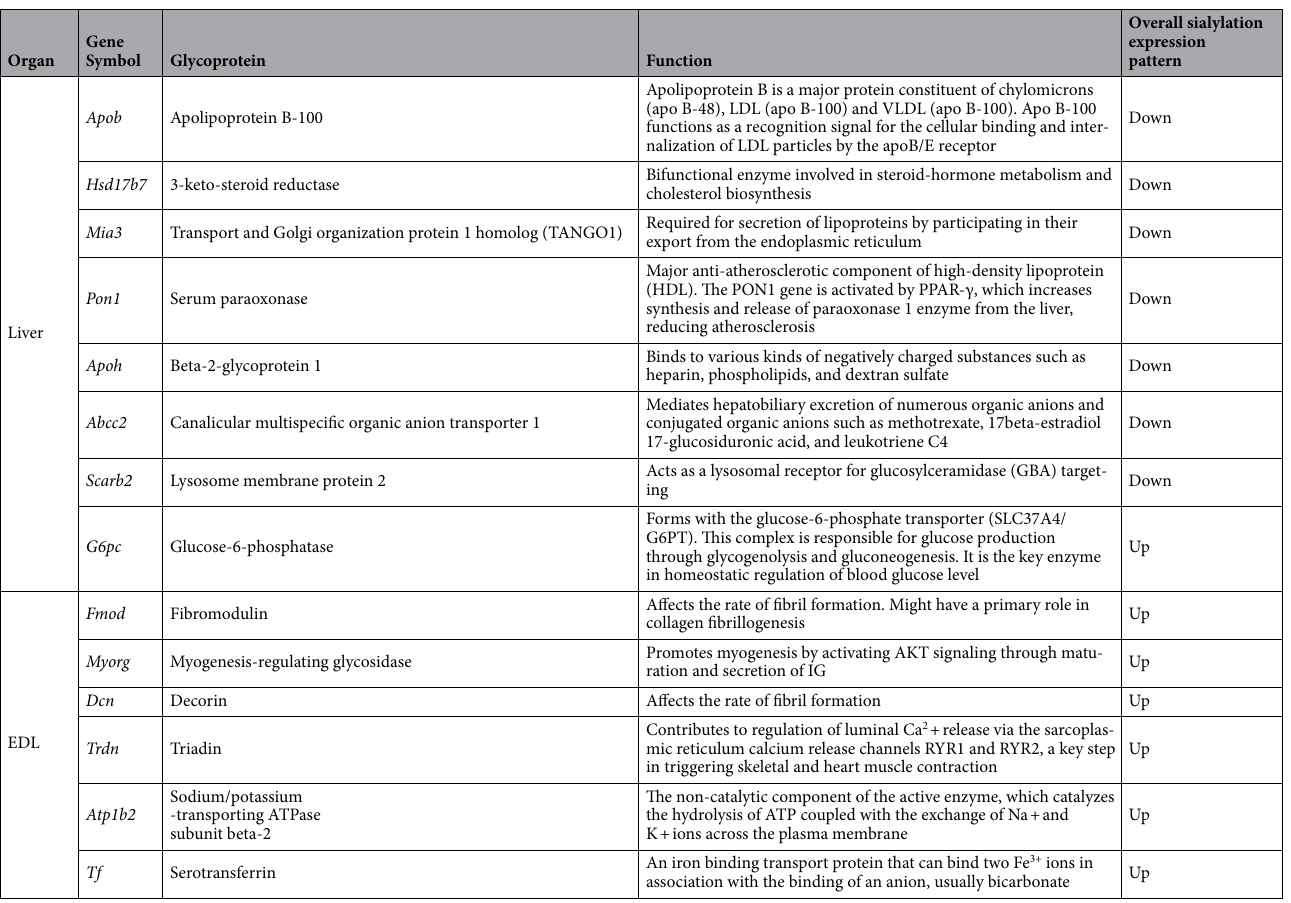
Table 1. Identification of sialylated glycoproteins involved in lipid metabolism and muscle